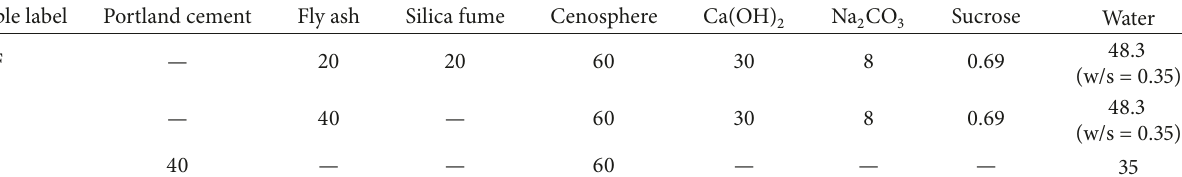
Table 1: Mixture proportions of the samples: w/s denotes water-to-solid ratio (in grams).